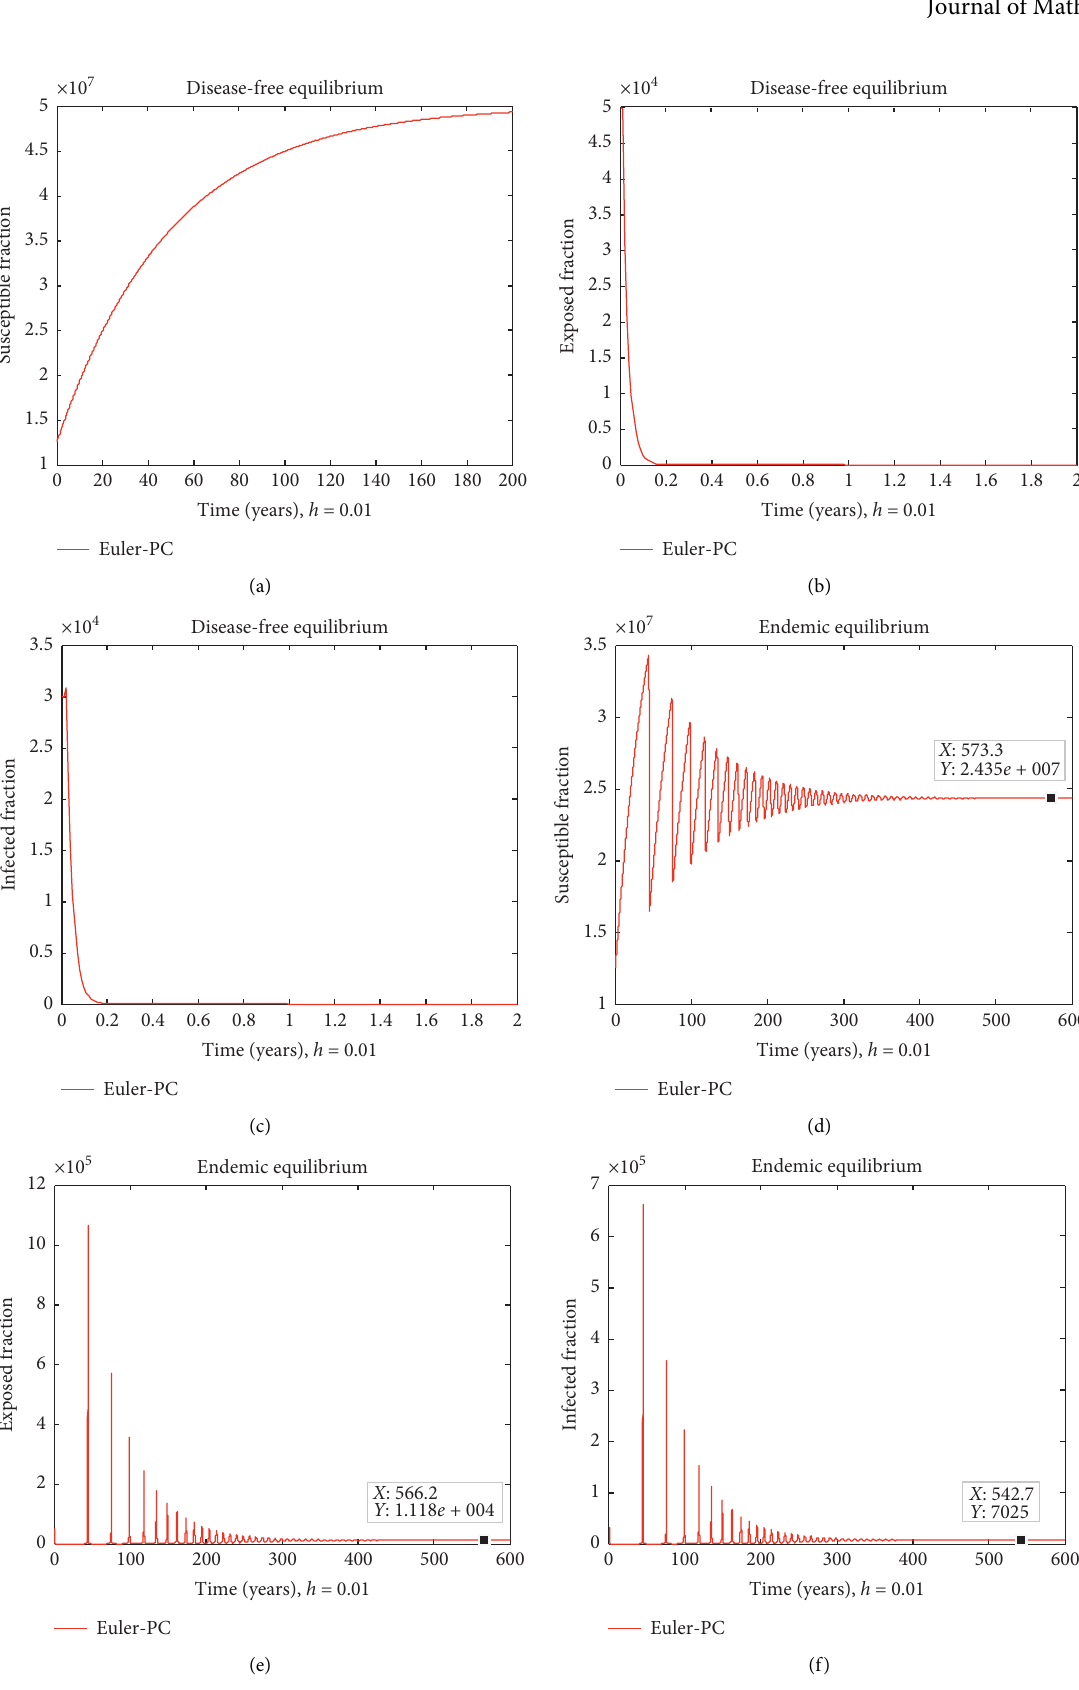
Figure 7: Time plots of population using the Euler-PC method with h � 0 . 01